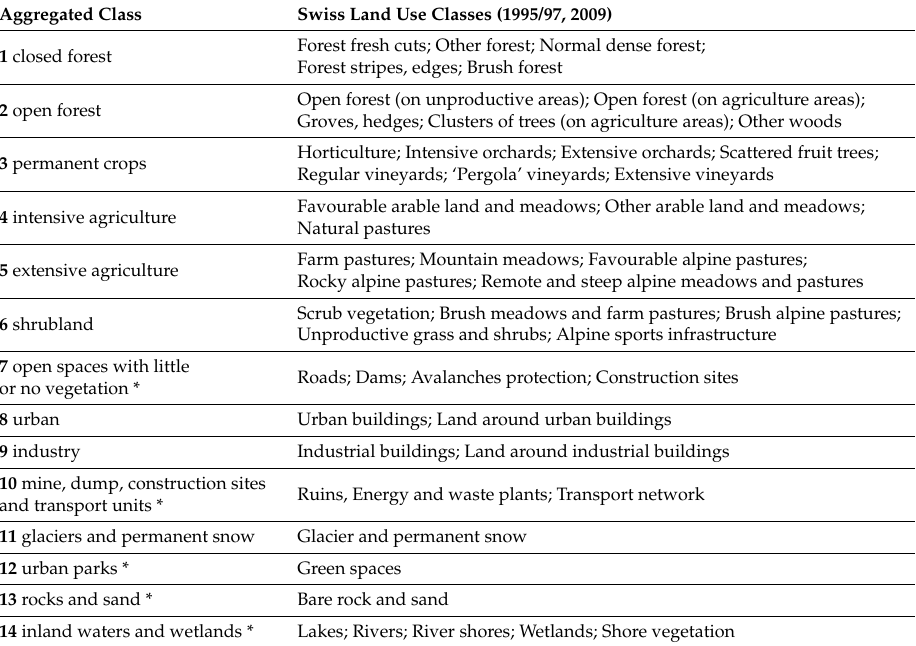
Table 1. Original Swiss land use classes and new aggregated classes. * Classes that were not modelled and, thus, considered static.